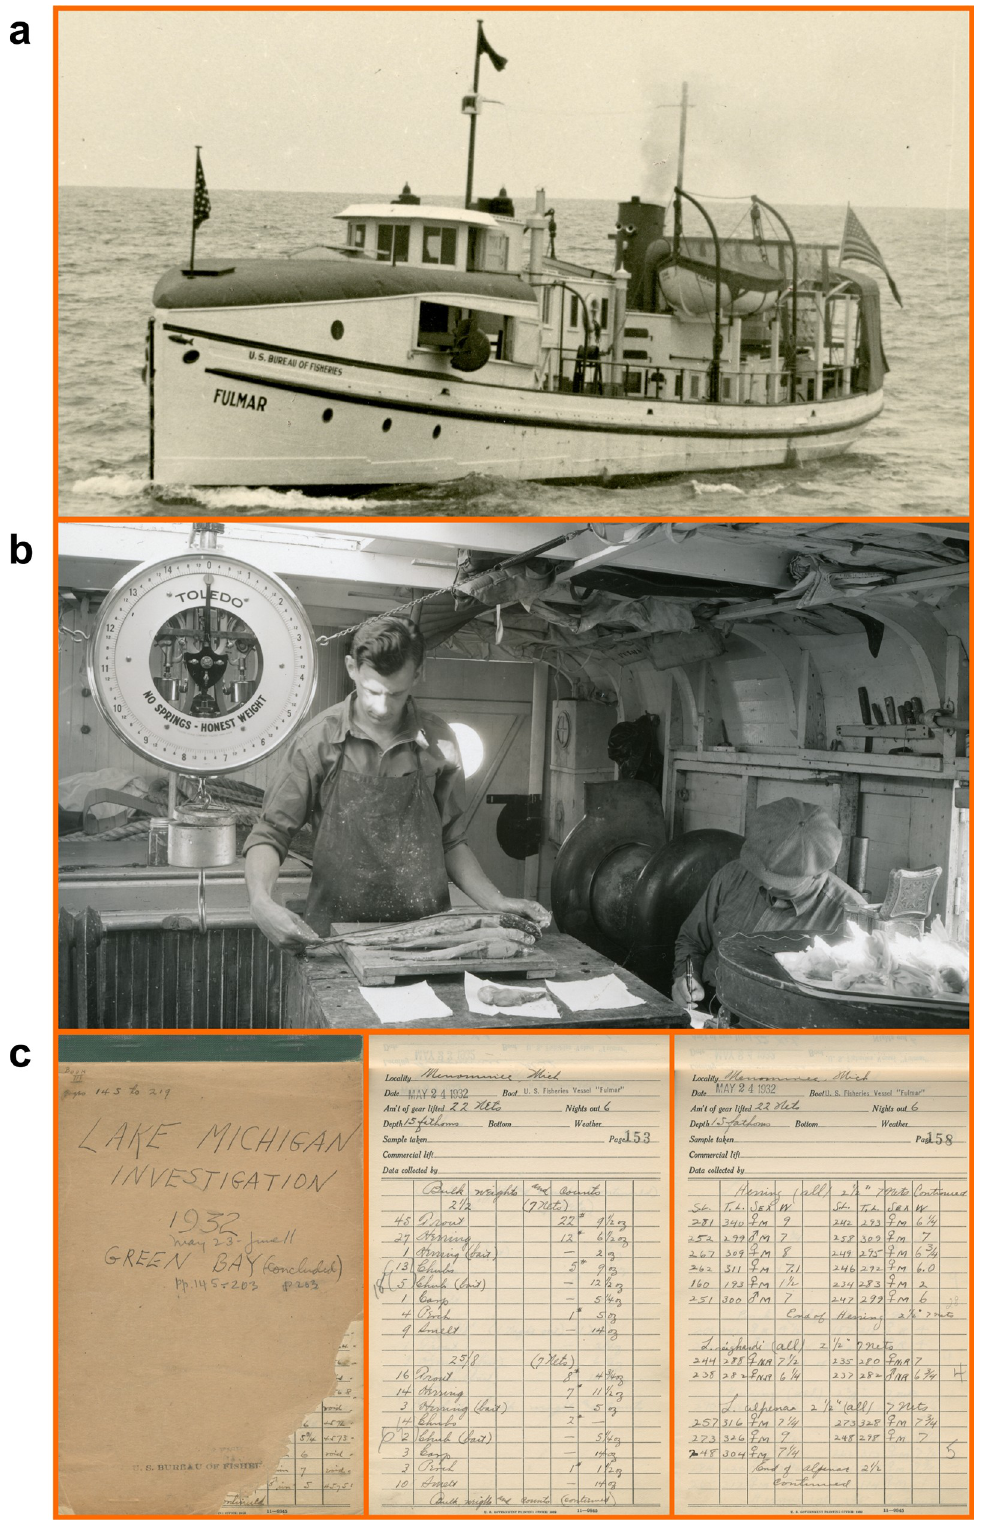
Fig 2. Selected photos for the Fulmar survey (credit: U.S. Geological Survey). (A) The U.S. Bureau of Fisheries research vessel Fulmar . (B) Researchers onboard taking and recording biological measurements. (C) Data notebooks.